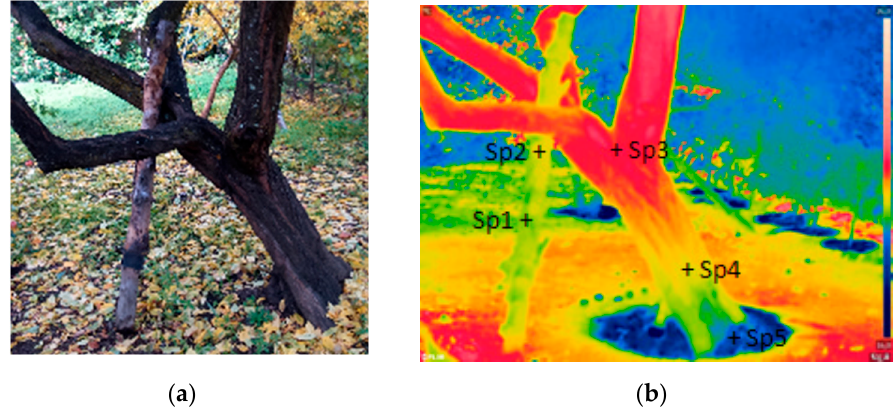
Figure 3. A tree ( Prunus domestica ) and a wooden stake that supports it: ( a ) photograph; ( b ) IRT thermogram (passive mode). Temperature values (°C): Sp1 = 20.0; Sp2 = 20.5; Sp3 = 21.5; Sp4 = 20.5; and Sp5 = 19.5. Adapted from Reference [2].